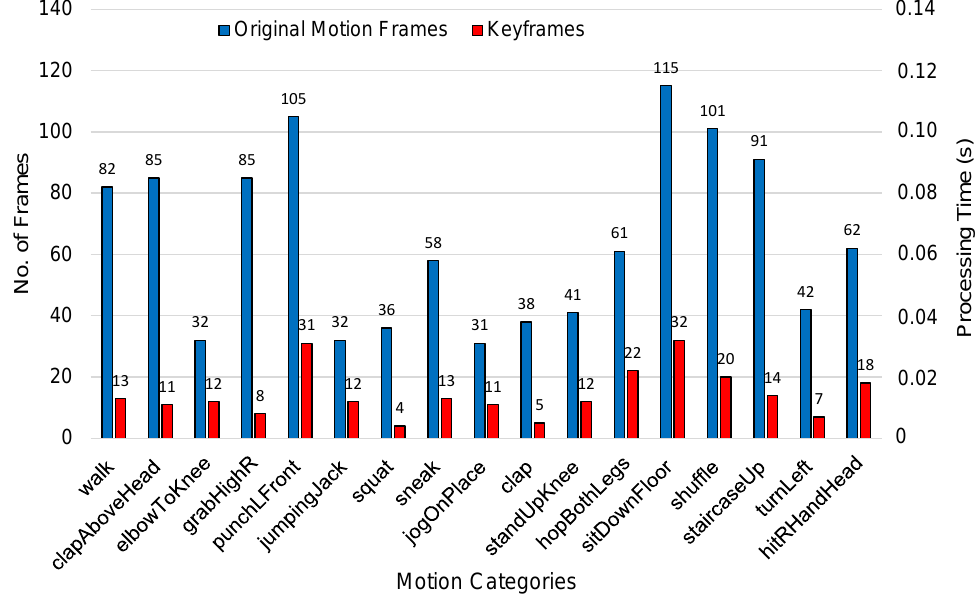
Figure 4. A comparison in terms of the number of frames between the keyframes extracted through Algorithm 1 against the original total number of frames for different types of motions. The processing time for the extraction of keyframes (seconds/frame) is also